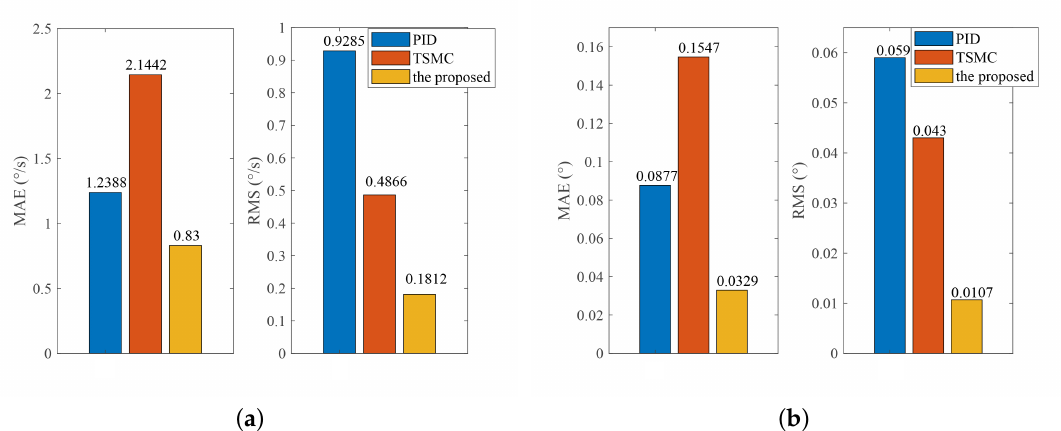
Figure 11. Simulation performance indexes under Case III: ( a ) Indexes of speed deviation; ( b ) indexes of angular